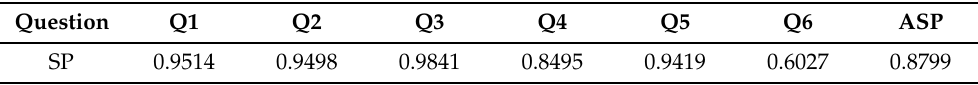
Table 2. Satisfaction ratio for all of the